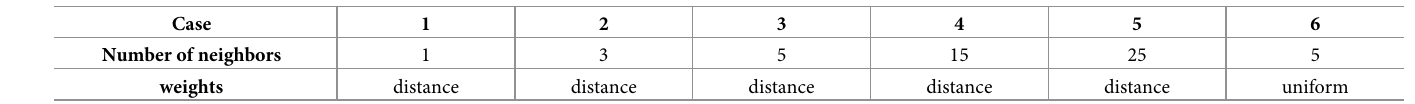
Table 1. Cases at different parameter